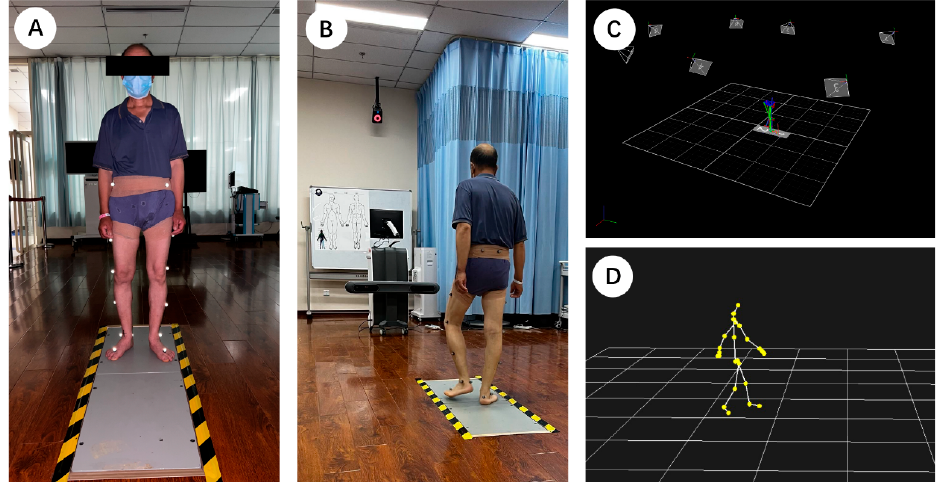
Figure 2. ( A ): Static calibration procedure of the Vicon system. ( B ): Simultaneous capture by Odonate and Vicon. ( C ): Data processing in Vicon Nexus software. ( D ): Data processing in Odonate software.